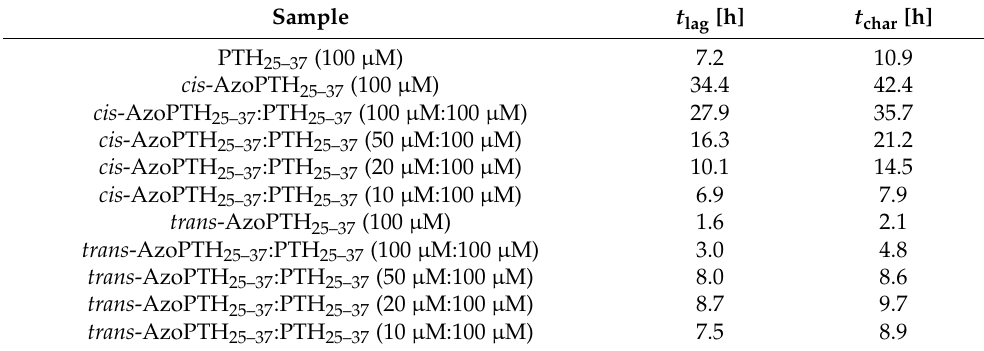
Figure 4. ThT-monitored fibrillization assay of PTH 25–37 , cis -AzoPTH 25–37 , and trans -AzoPTH 25–37 (average of triplets; T = 37 ◦ C, buffer = 50 mM Na 2 HPO 4, pH = 7.4): (black) PTH 25–37 (100 µ M), (red) trans -AzoPTH 25–37 (100 µ M), and (blue) cis -AzoPTH 25–37 (100 µ M). Table 1. Fibrillization parameters ( t lag , t char ) of PTH 25–37 , cis -AzoPTH 25–37 , trans -AzoPTH 25–37 ,